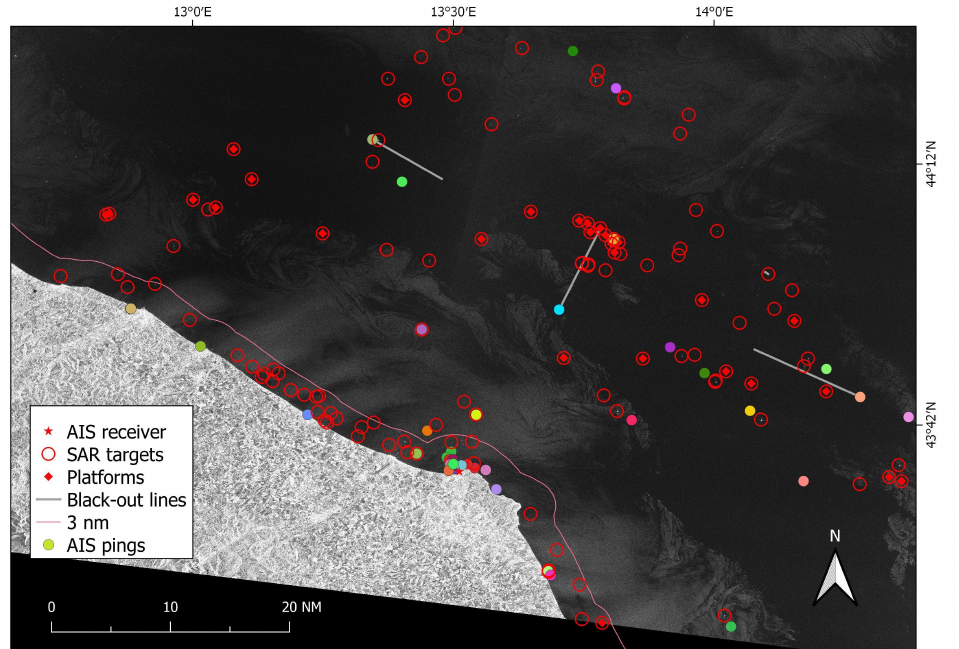
Figure 6. VV polarization of the Sentinel-1 image used as example, SAR targets (red circles) and selected AIS data (colored points and grey lines). AIS positions are categorized by